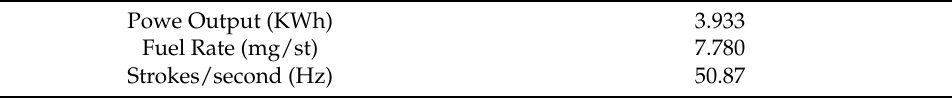
Table 11. Reference values to find diesel mass consumption from generated